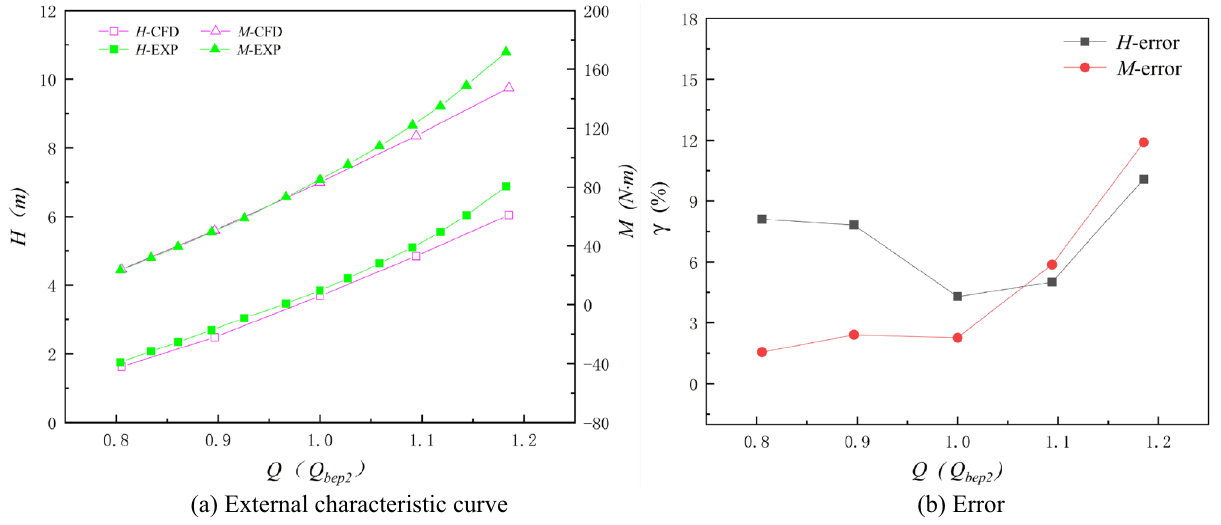
Figure 22. Comparison of the numerical simulation results and experimental results of the